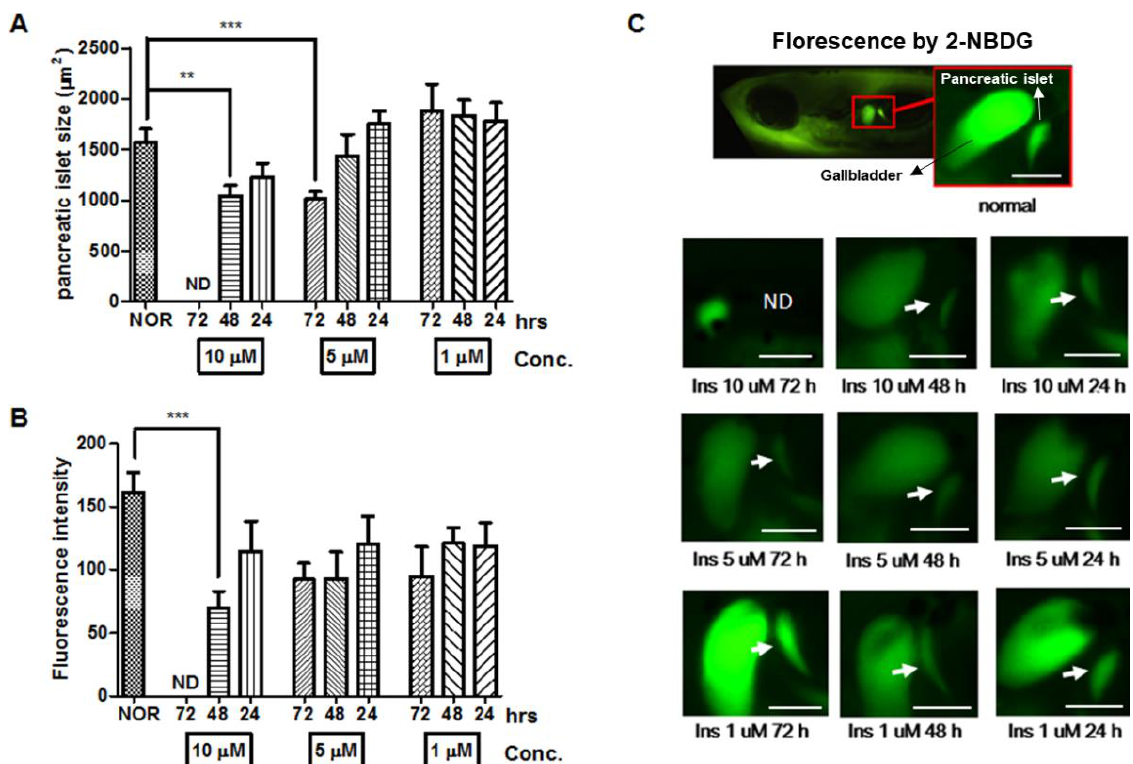
Figure 2. Dose- and time-dependent changes in pancreatic islet following insulin (INS) treatment. ( A ) Dose- and time- dependent changes in pancreatic islet size caused by insulin were analyzed using Focus Lite software ( n = 20). (**) p < 0.01 and (***) p < 0.001; compared to normal group (NOR). ( B ) Fluorescence intensity of the pancreatic islet following insulin treatment using image J software. (***) p < 0.001; compared to NOR. ( C ) Fluorescent microscopic images of the pancreatic islet. The white arrow indicates the location of the pancreatic islet. Scale bar = 100 μm.